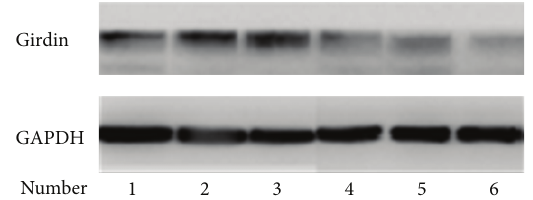
Figure 2: Girdin protein was upregulated in high-grade Gliomas cancertissueswhencomparedtolow-gradetumortissuesinwestern blot analysis ( 𝑃 = 0.01